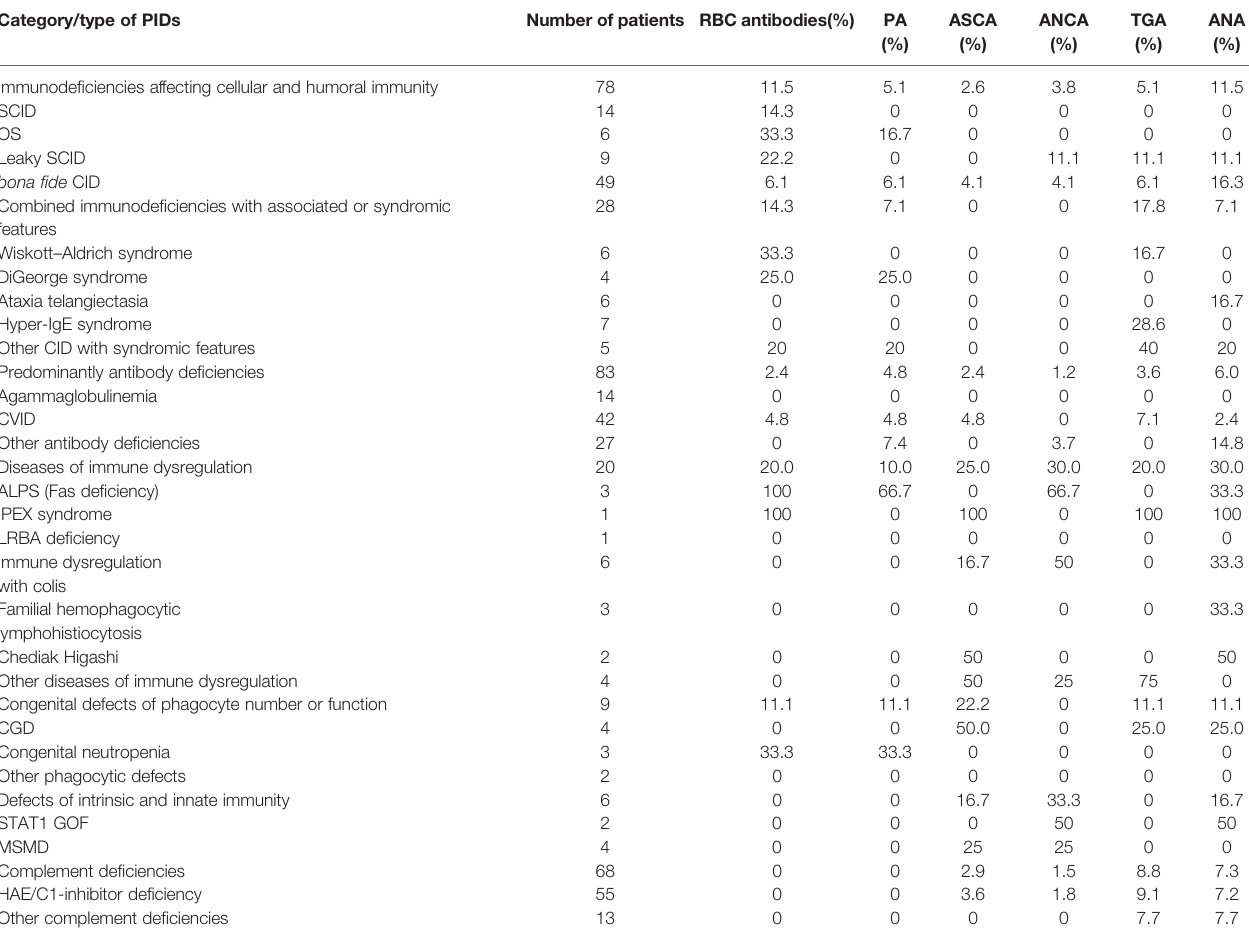
TABLE 7 | Distribution of autoantibodies among different categories/types of PIDs. Category/type of PIDs Number of patients RBC